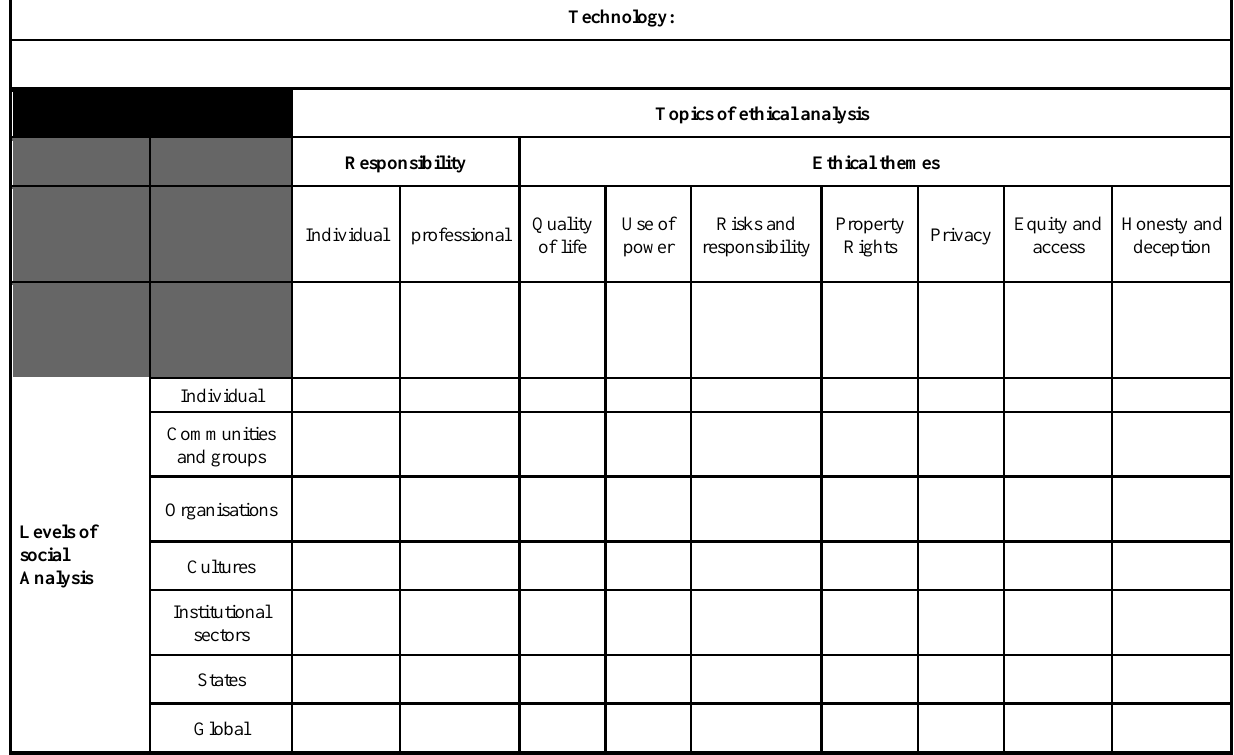
Table 1. Frame for ethical analysis